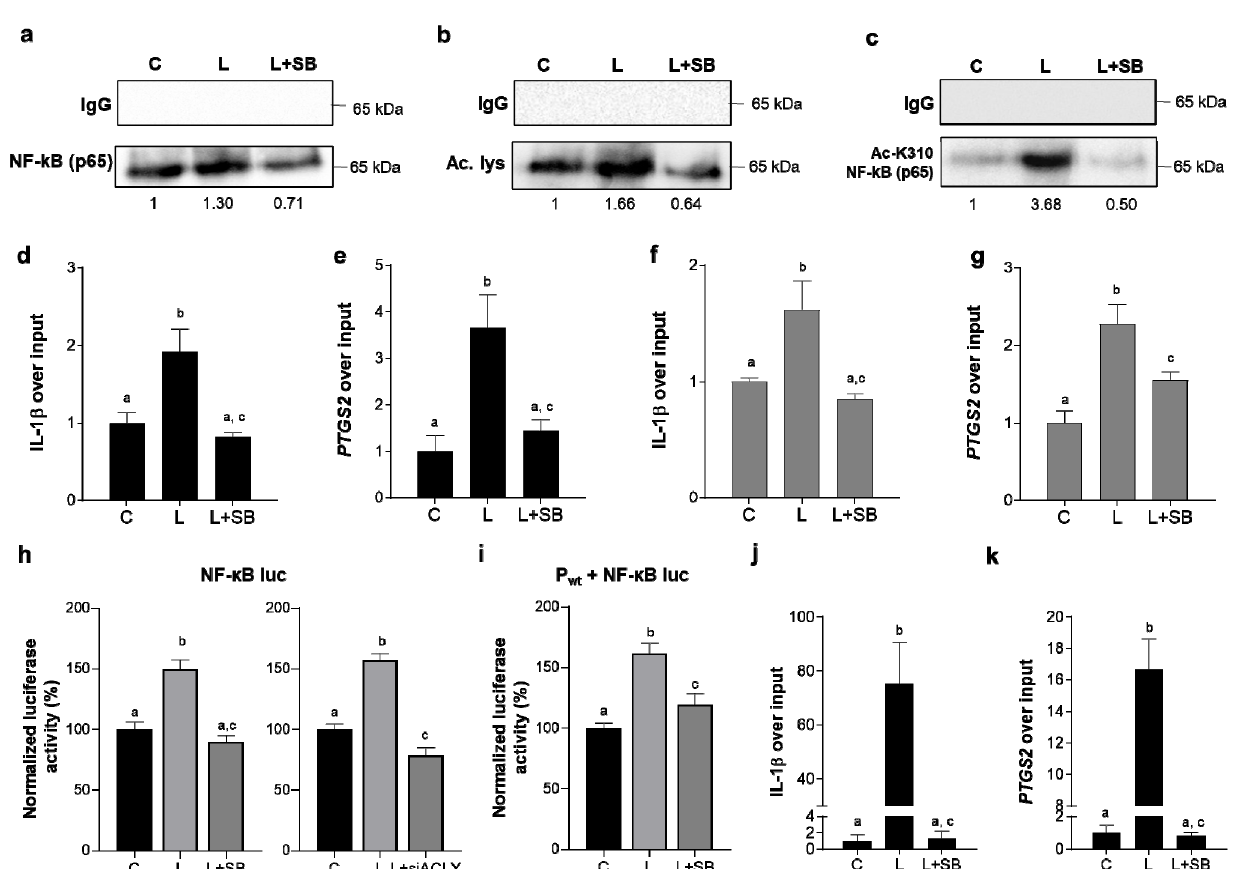
Figure 3. Nuclear ACLY fostered NF- κ B acetylation and its activity. Human PBMC-derived macrophages were triggered by LPS in the presence or absence of SB and ( a ) immunoprecipitated with an antibody directed to acetylated lysine and analyzed by western blot with an anti-NF- κ B (p65) antibody. ( b ) In macrophages triggered by LPS, with or without SB, NF- κ B (p65) was immunoprecipitated with a specific antibody, and then an antibody against acetylated lysine was used in western blot experiments. ( c ) Macrophages treated and immunoprecipitated as in ( b ) were analyzed by western blot with an anti-NF- κ B p65 (acetyl K310) antibody. In ( a – c ), IgG is the negative control. ( d , e ) Human PBMC-derived macrophages, treated as in ( a ), were used to carry out chromatin immunoprecipitation (ChIP) analysis with an antibody against subunit p65 of NF- κ B, and then specific primers were used in the real-time PCR experiments to analyze the IL-1 β and PTGS2 gene promoters. ( f , g ) Human PBMC-derived macrophages, treated as reported above, were used to carry out ReChIP experiments with a first antibody against subunit p50 of NF- κ B and then with an anti-NF- κ B p65 (acetyl K310) antibody. Specific primers were used in the real-time PCR experiments to analyze the IL-1 β and COX2 gene promoters. ( h ) Luciferase activity was quantified in iBMDM cells transiently transfected with NF- κ B luc in the presence or absence of SB (left panel) or with siRNA targeting human ACLY (siACLY) or control scramble siRNA (right panel) and triggered by LPS. ( i ) iBMDM cells transfected with NF- κ B luc plus an ACLY overexpression vector (P wt ) and triggered by LPS in the presence or absence of SB were used for luciferase luminescence detection. ( j , k ) Human PBMC-derived macrophages treated with LPS for 3 h in the presence or lack of SB-204990 (SB) were used to carry out chromatin immunoprecipitation (ChIP) analysis with an antibody against acetylated histone H3, and then specific primers were used in the real-time PCR experiments to analyze the IL-1 β and PTGS2 gene promoters. In ( d – k ), data are representative of 3 independent experiments and are presented as means ± SD (error bars). Different letters above the bars indicate significant differences between treatments at p < 0.05, according to Tukey’s post hoc test performed after one-way ANOVA. Western blotting data presented are representative of at least 3 independent experiments, and the mean of protein levels normalized versus mean of proteins in untreated cells (C) is reported under each